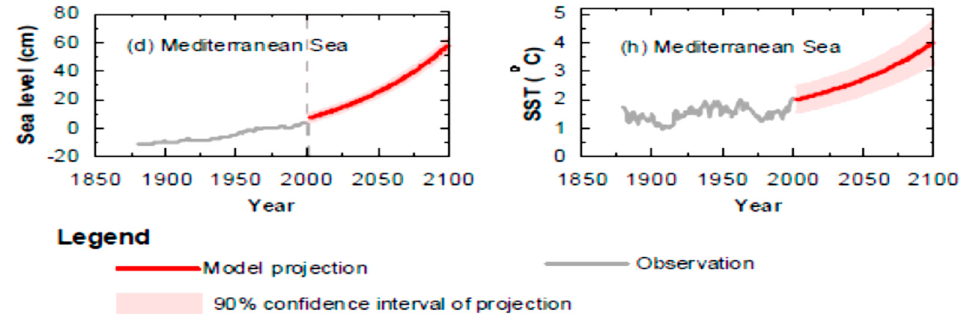
Figure 2. Flowchart of the methodology.